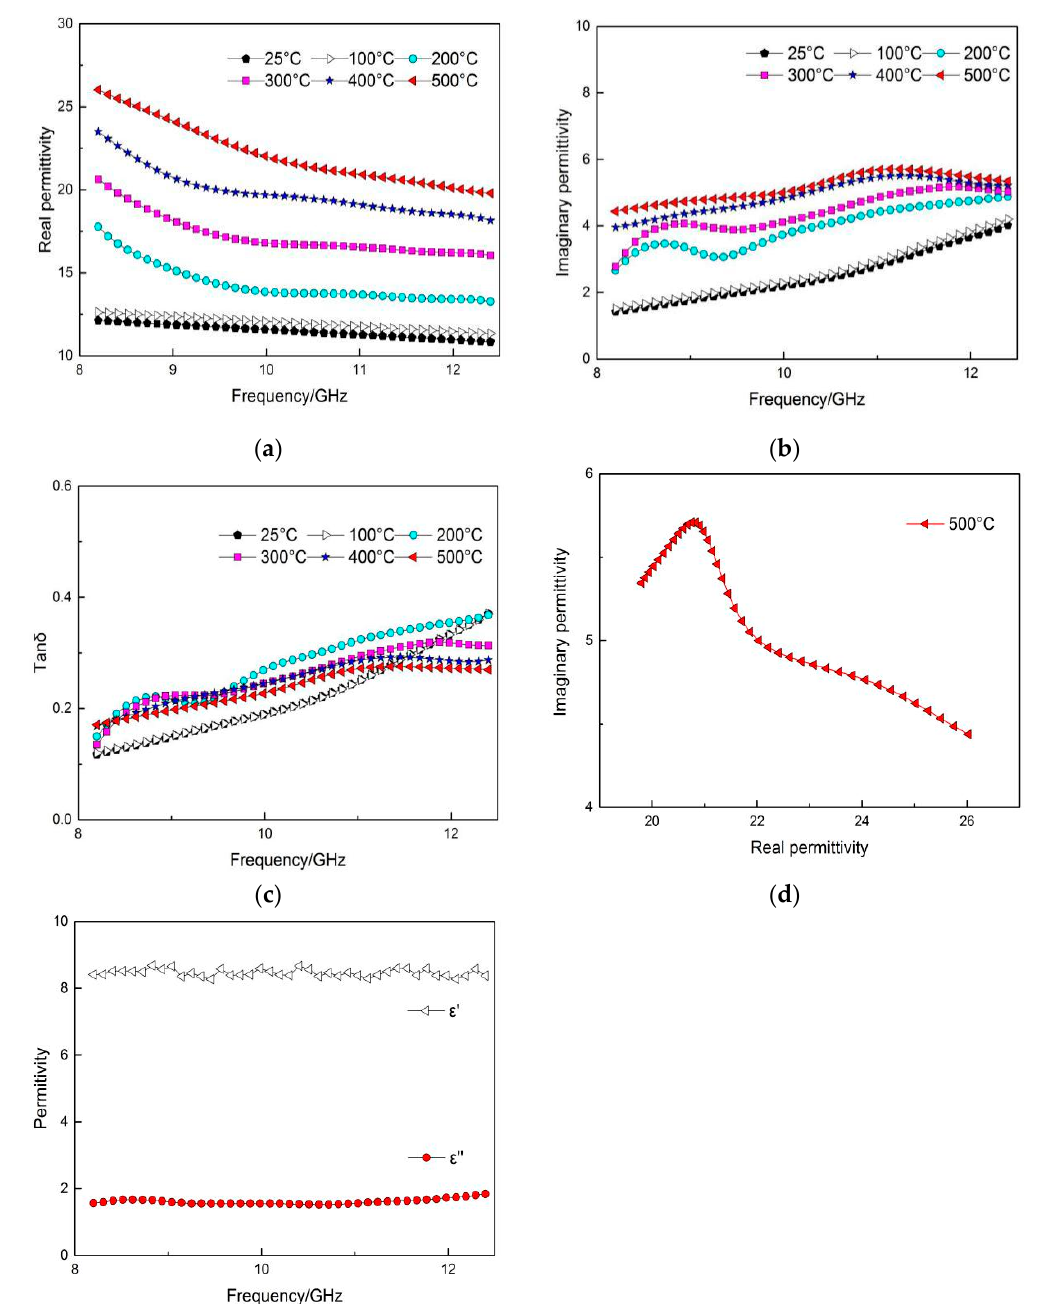
Figure 6. Dielectric properties of Al 2 O 3 -MoSi 2 -Cu composite coating: ( a ) ε′ of Al 2 O 3 -MoSi 2 -Cu composite coating; ( b ) ε″ of Al 2 O 3 -MoSi 2 -Cu composite coating; ( c ) Tan δ of Al 2 O 3 -MoSi 2 -Cu composite coating; ( d ) the Cole–Cole plot of Al 2 O 3 -MoSi 2 - Cu composite coating with the fitting date in 500 °C; ( e ) permittivity of Al 2 O 3 -MoSi 2 -Cu 2 O composite coating at room temperature (25 °C).